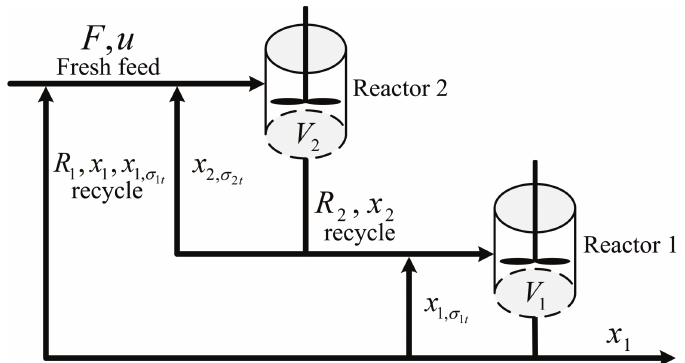
Figure 1. Two-stage chemical reactor with delayed recycle